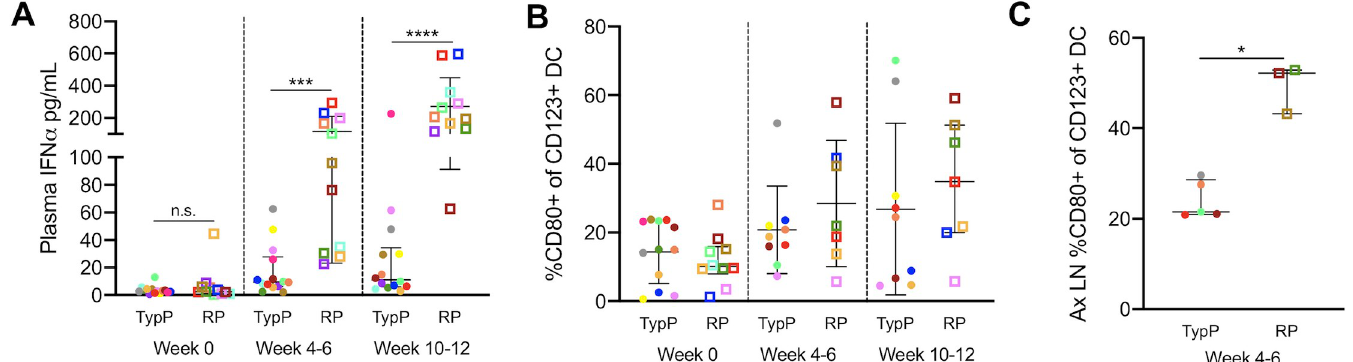
Fig 7. Elevated Interferon- α and pDC activation in RP infants. Plasma IFN α concentrations were measured by ELISA at multiple time points in TypP and RP infants ( A ). Proportions of activated CD80+ plasmacytoid dendritic (CD123+) in PBMC from TypP ( closed circles ) and RP ( open squares ) infants were evaluated in blood ( B ) and lymph nodes ( C ) by flow cytometry. Statistical tests used to compare infant groups were carried out as described in the methods � = p < 0.05, ��� = p < 0.001, ���� = p < 0.0001. Error bars are shown as either mean with standard deviation or median with interquartile range based on data distribution.